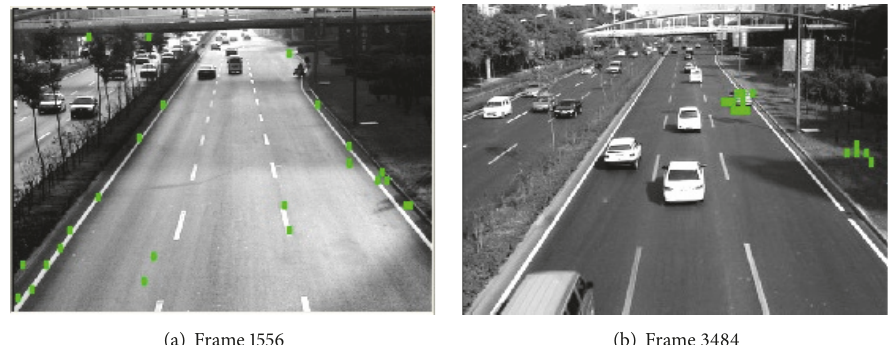
Figure 14: Xi’an South Second Ring Road.